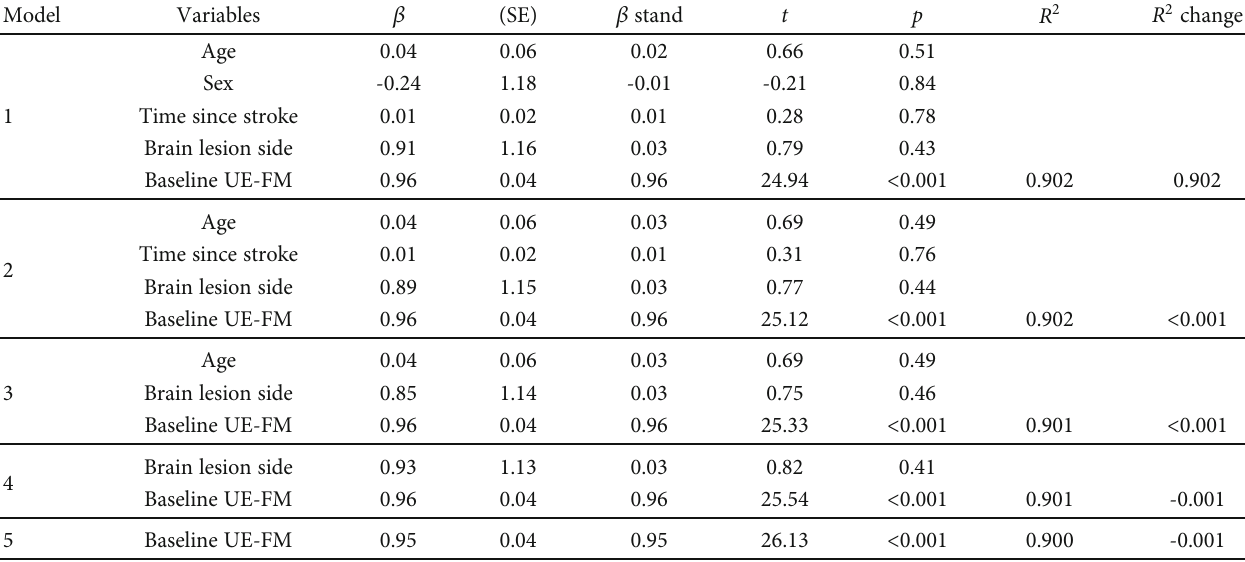
Table 2: Results of the regression